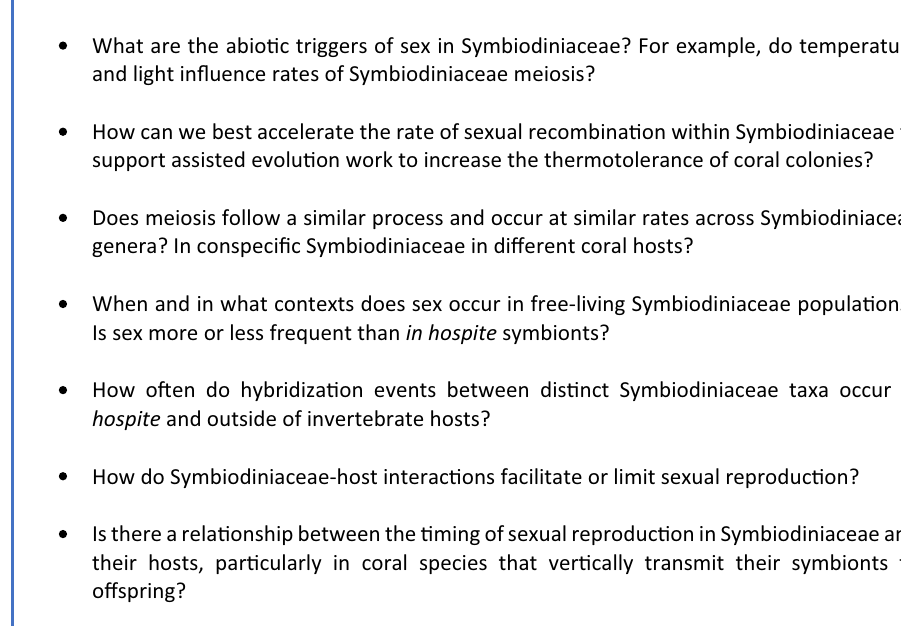
Figure 12. Outstanding question box. Summary of important questions for future